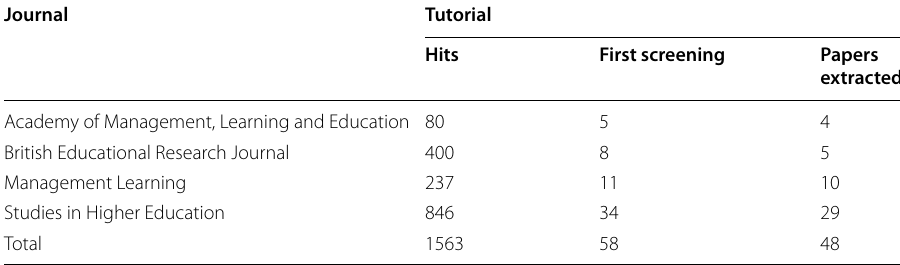
Table 2 Number of selected articles by journal